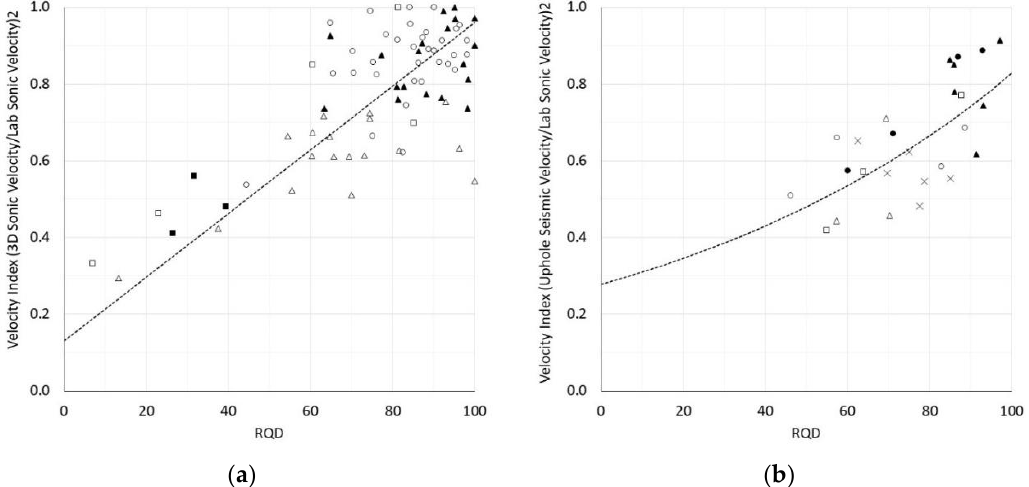
Figure 4. RQD vs. velocity index graphs for ( a ) a threshold of 15 cm (assumed linear correlation with R2 of 0.46) and ( b ) a threshold of 10 cm (assumed power correlation with R2 of 0.46) (after [9]).